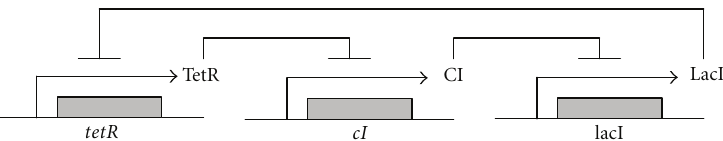
Figure 7: Synthetic transcriptional cascade loop for repressilator. TetR represses lacI, LacI represses cI , and CI represses tetR .